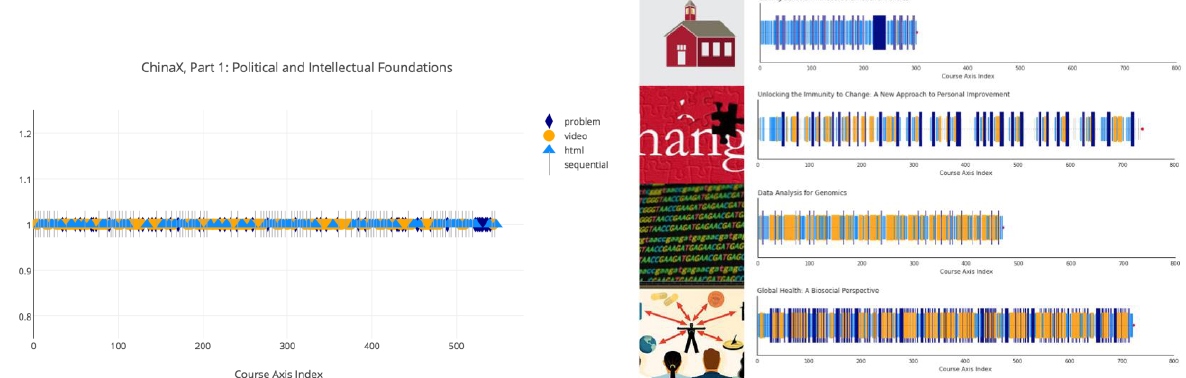
Figure 3. Video is just one component that needs to work with other equally important components (e.g., problem sets, hypertext) (left), while the actual mix of these elements might differ significantly among courses